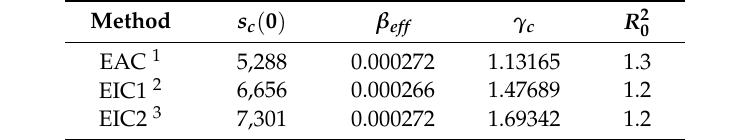
Table 5. Model parameter estimates for Tolima, Colombia (first outbreak).